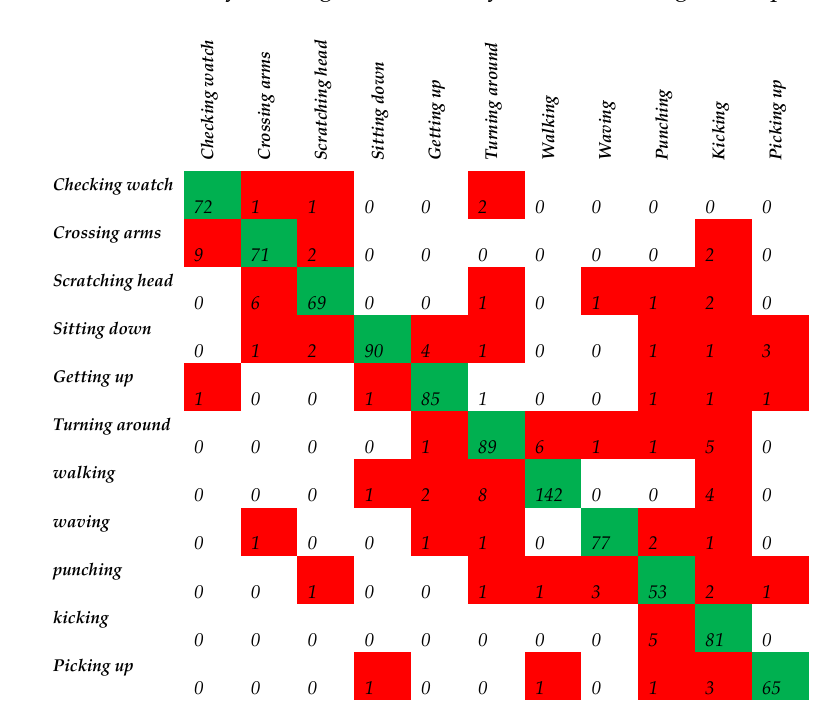
Table 2. Comparison with state ‐ of ‐ the ‐ art methods on IXMAS (INRIA Xmas Motion Acquisition Sequences) dataset.